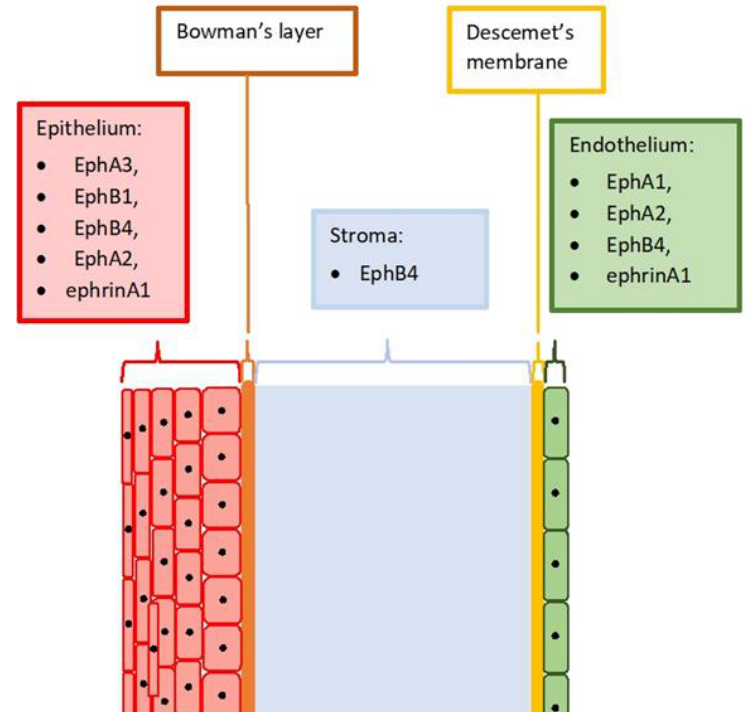
Figure 1. Diagram of a healthy cornea. Next to the names of the individual layers, the Eph receptors and ephrins are mentioned, the presence of which has been known so far.